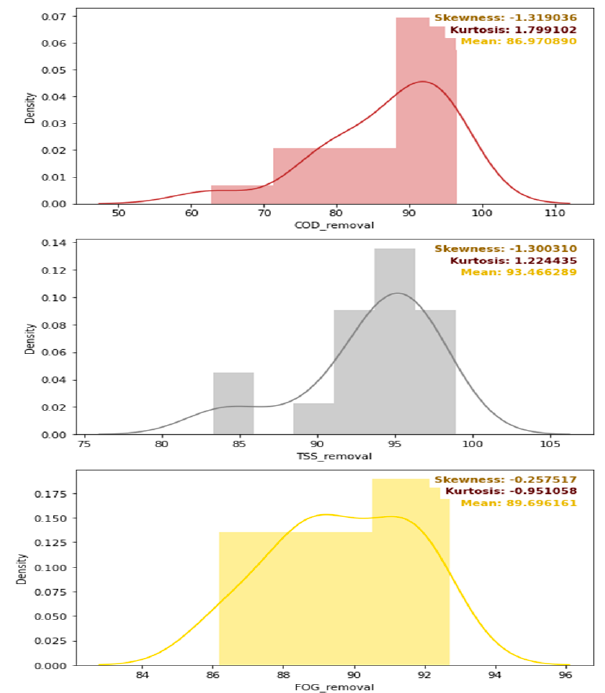
Figure 19. Density distribution, skewness, kurtosis, and mean values of the removal efficiencies of the DEGBR.